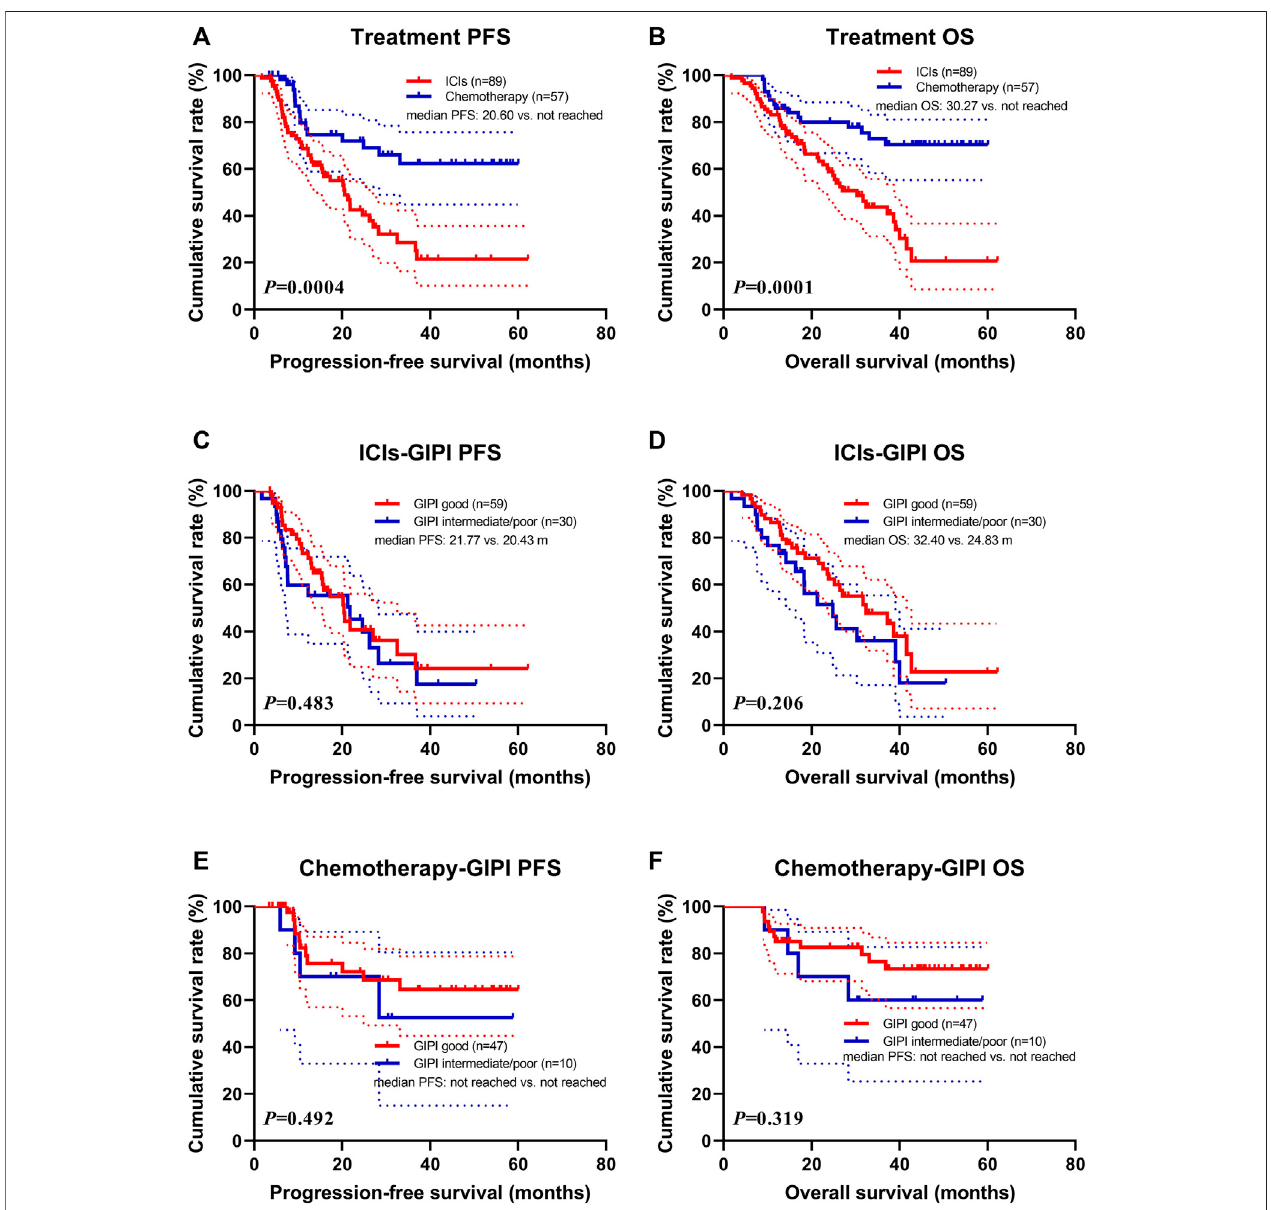
FIGURE 2 | Survival according to ICIs and GIPI groups for (A) progression-free survival (PFS) by treatment; (B) overall survival (OS) by treatment; (C) PFS by ICIs; (D) OS by ICIs; (E) PFS by chemotherapy; (F) OS by chemotherapy.